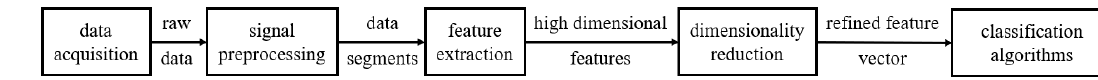
Figure 5. The pipeline of performing EMG pattern recognition.